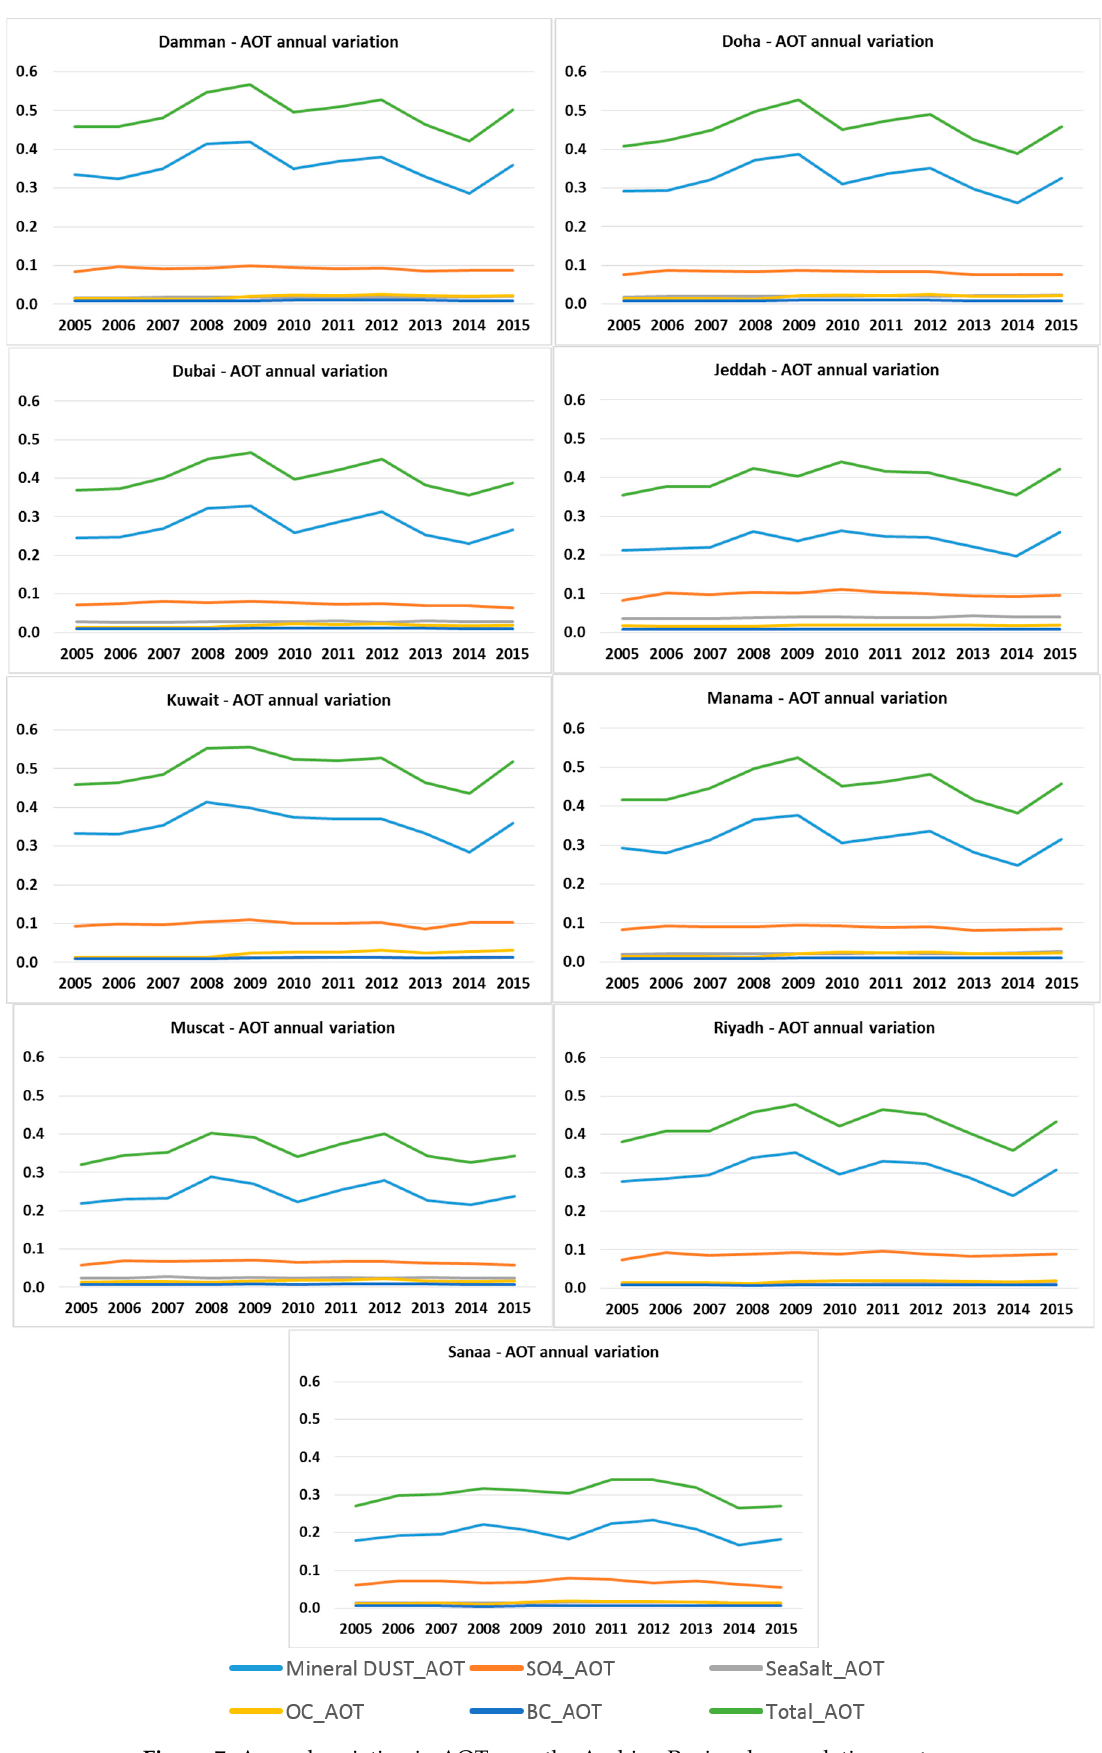
Figure 7. Annual variation in AOT over the Arabian Peninsula population centers.